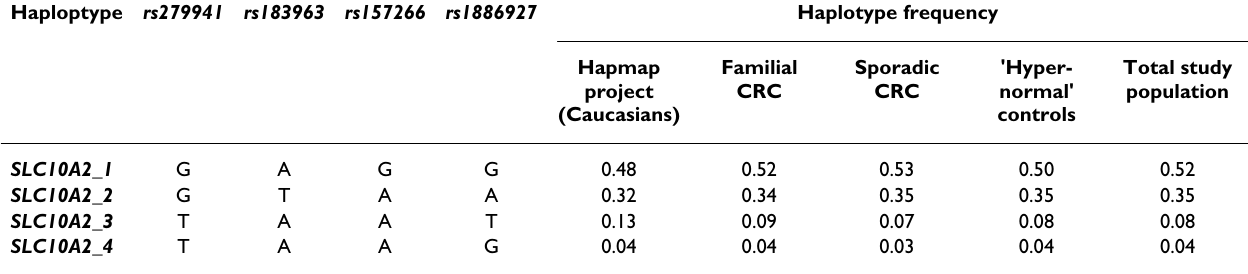
Table 4: SLC10A2 haplotype frequencies in patients and controls Haploptype rs279941 rs183963 rs157266